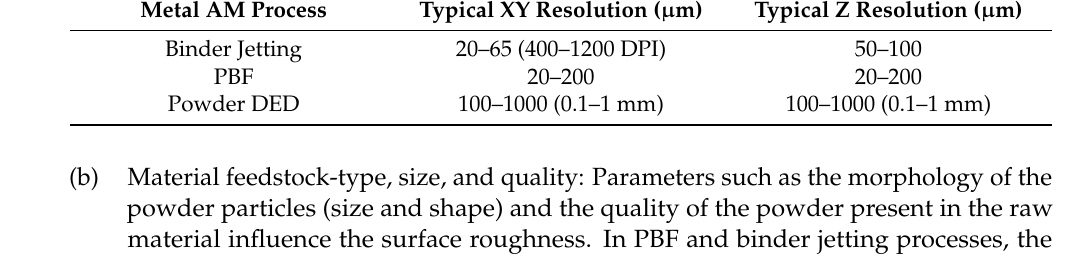
Table 3. XY and Z axis resolutions of various 3D print processes [139]. Metal AM